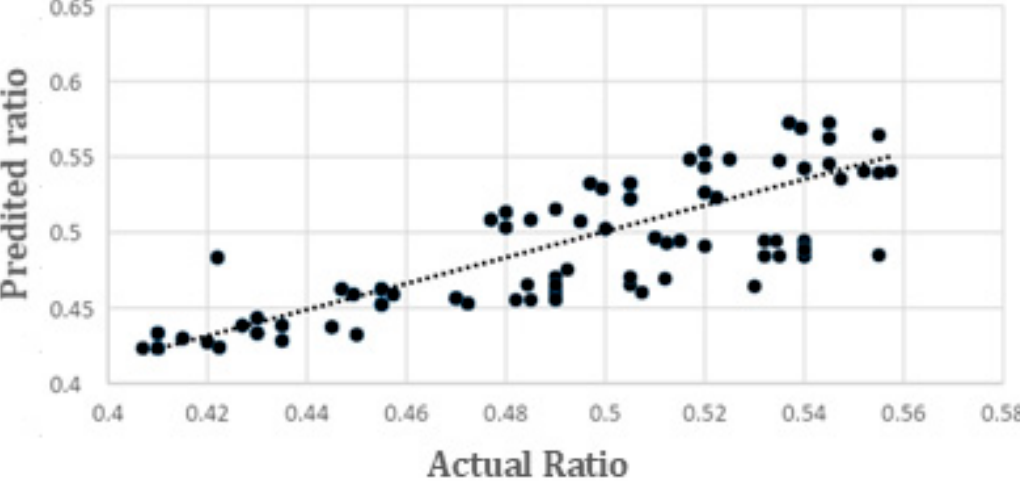
Figure 6. The ratio of the crystal structure severity using the Dns ‐ Net + regression with transfer learning versus the actual ratio detected by experts.